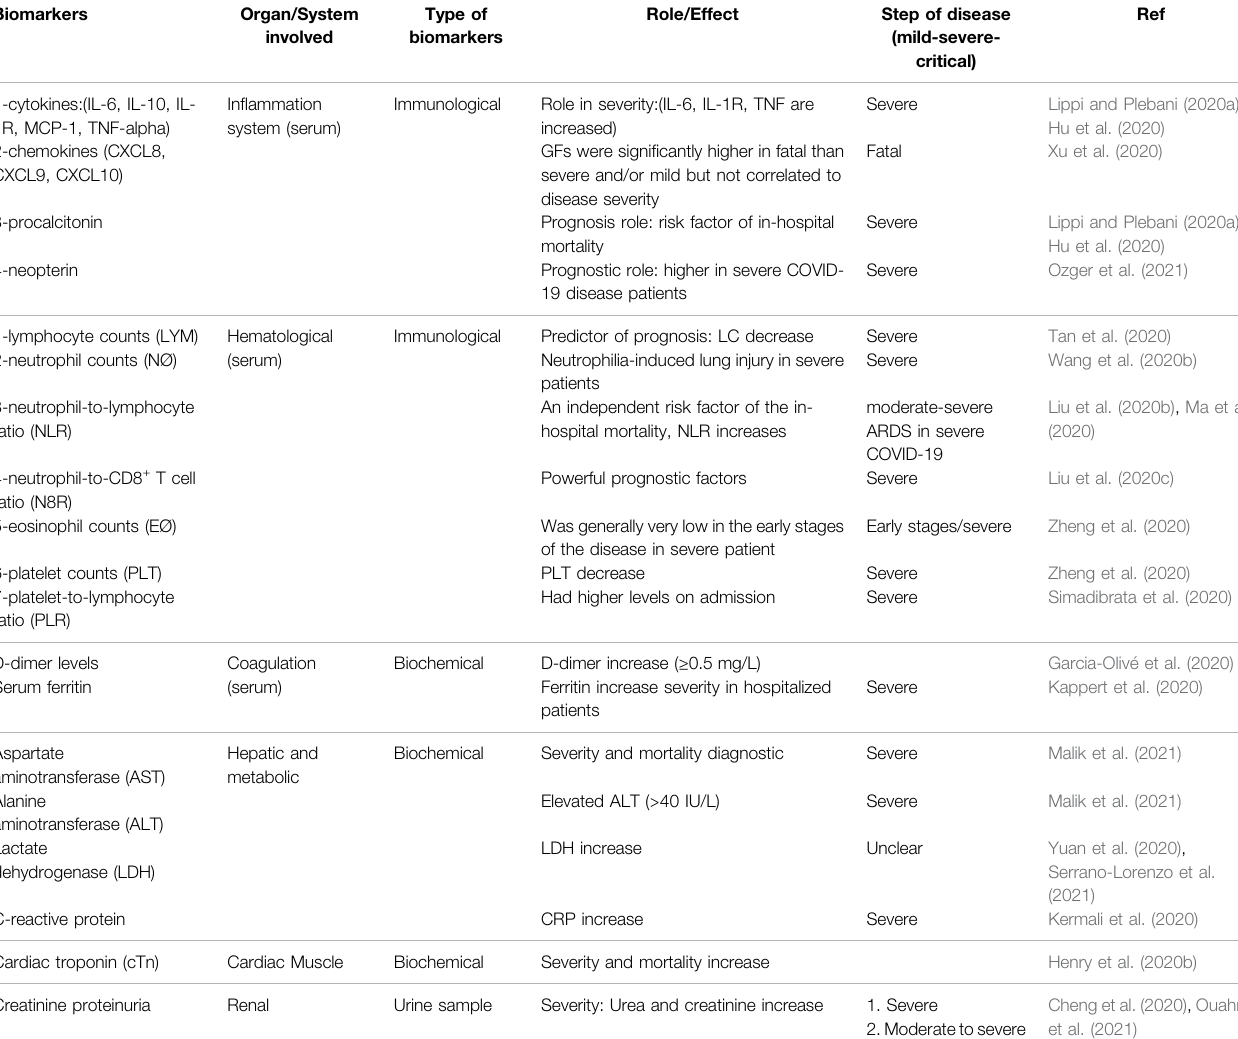
TABLE 1 | The future Biomarkers and diagnostic utility against